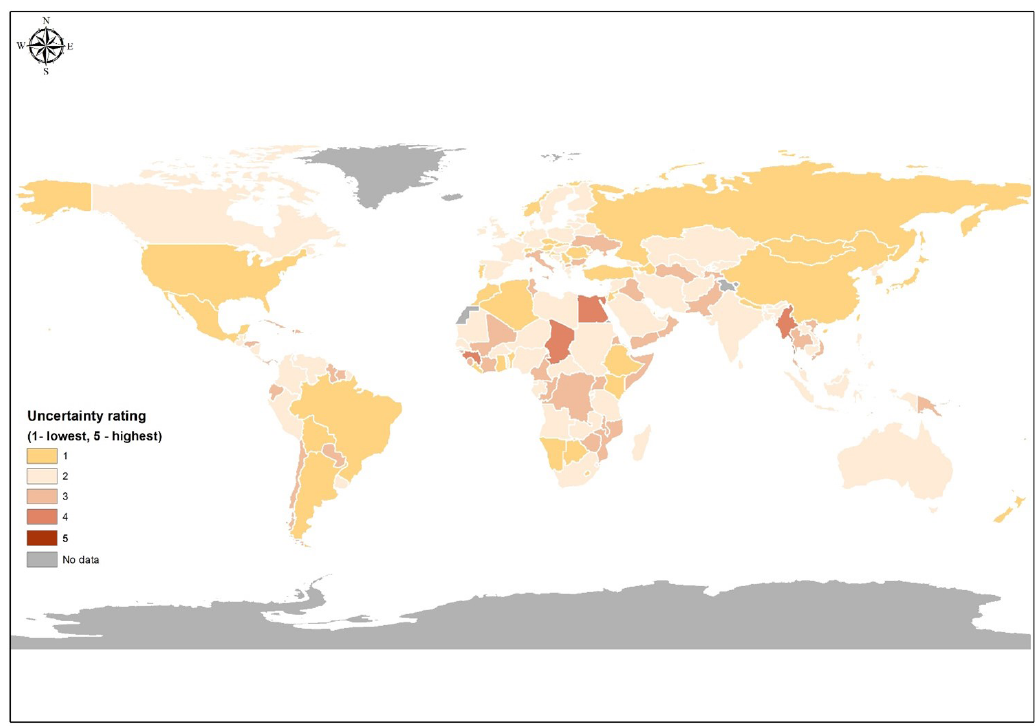
Figure 5. Subjective uncertainty rating for SPAM2010 input data by individual